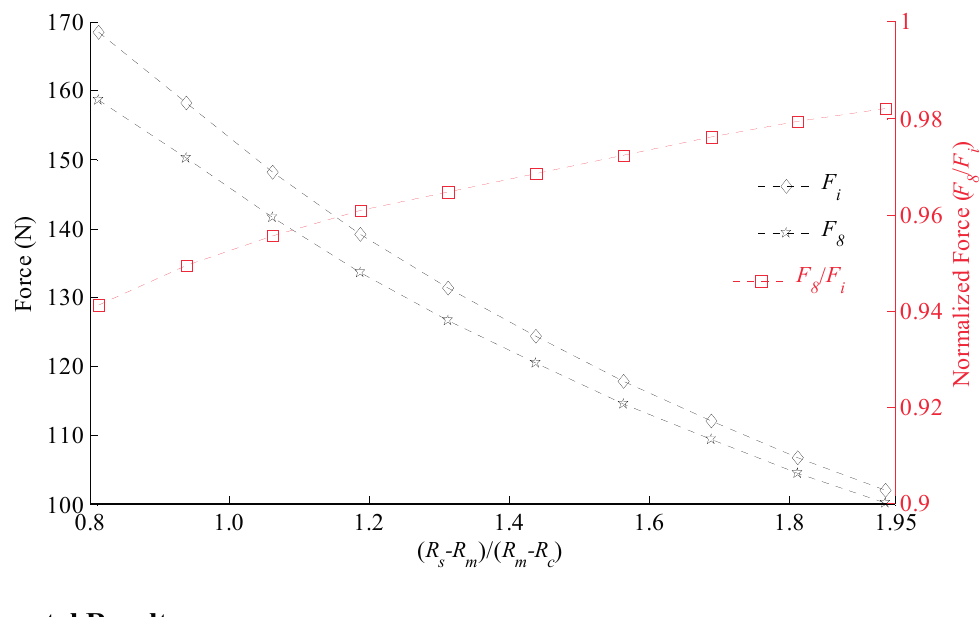
/F ) and axial force for an actuator with ideal 8 i – R )/( R – R s m m c